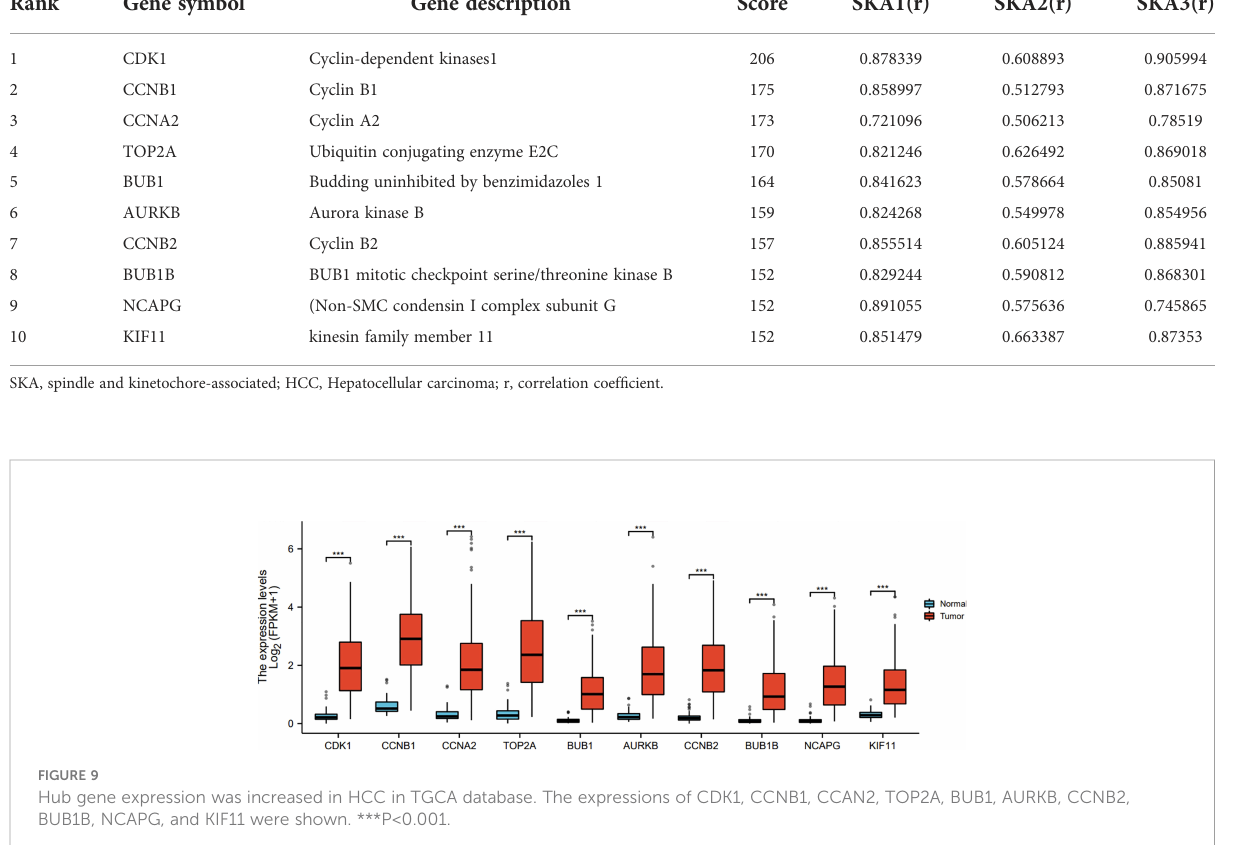
TABLE 3 The correlations between the representative 10 Hub genes with SKA1/2/3 in HCC patients. Rank